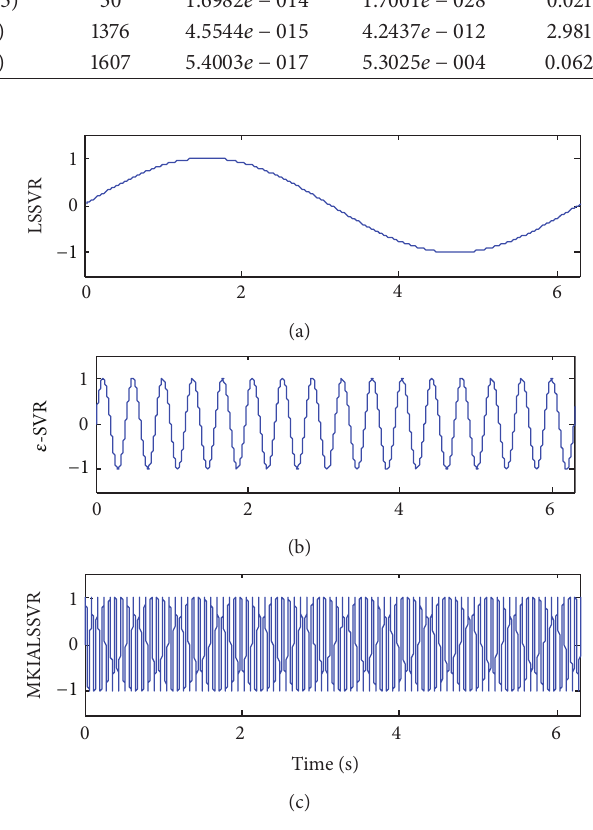
Figure 2: Time response of the three method